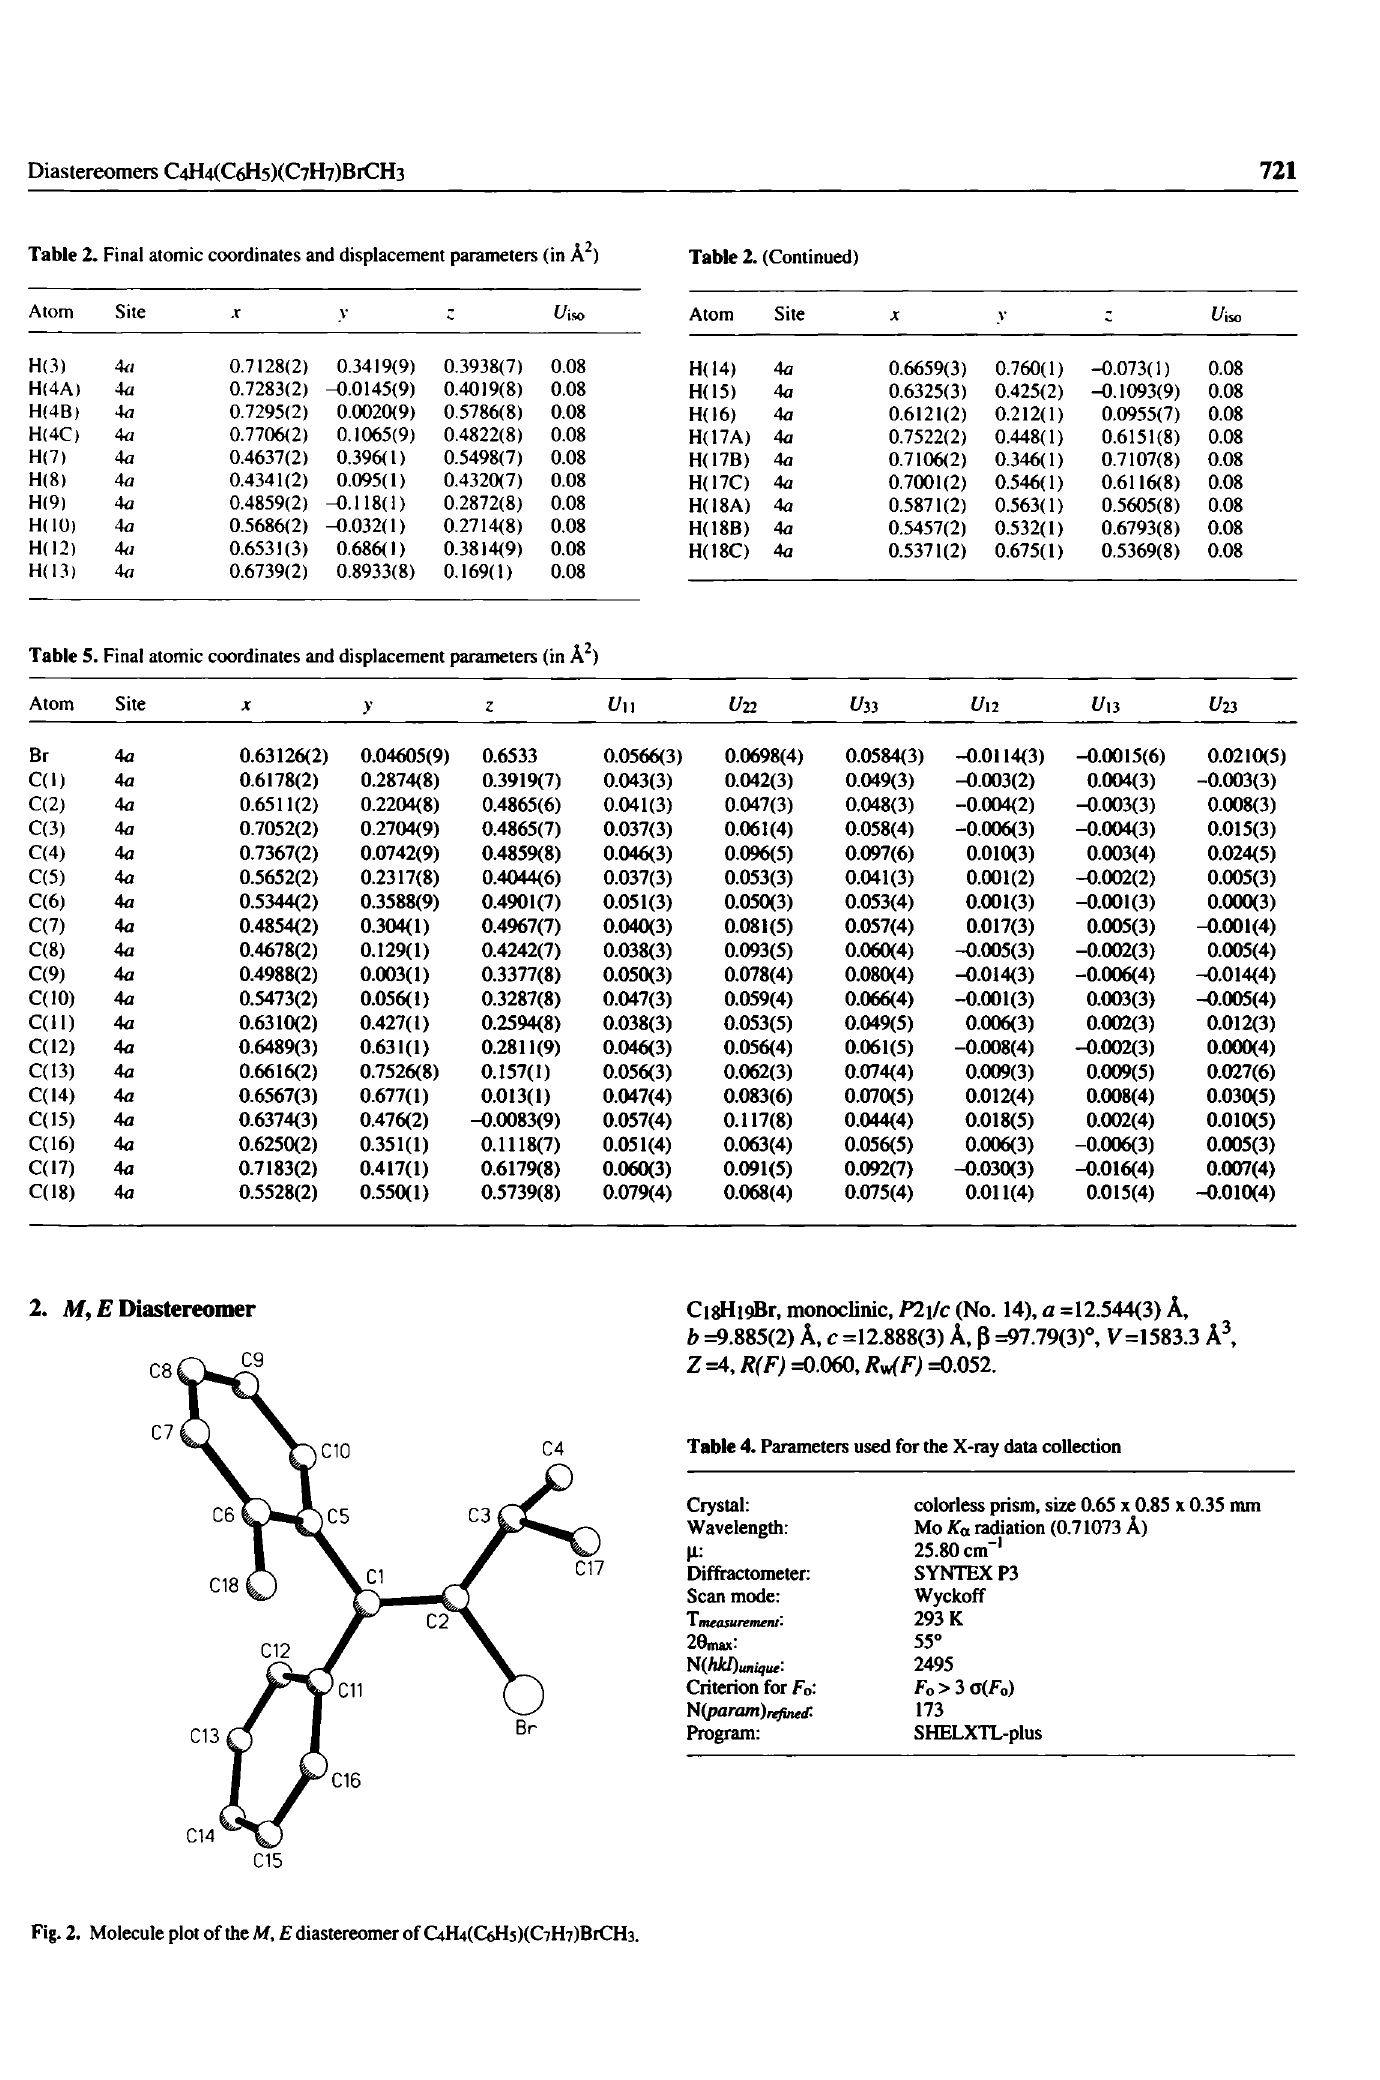
Fig. 2. Molecule plot of the M, E diastereomer of